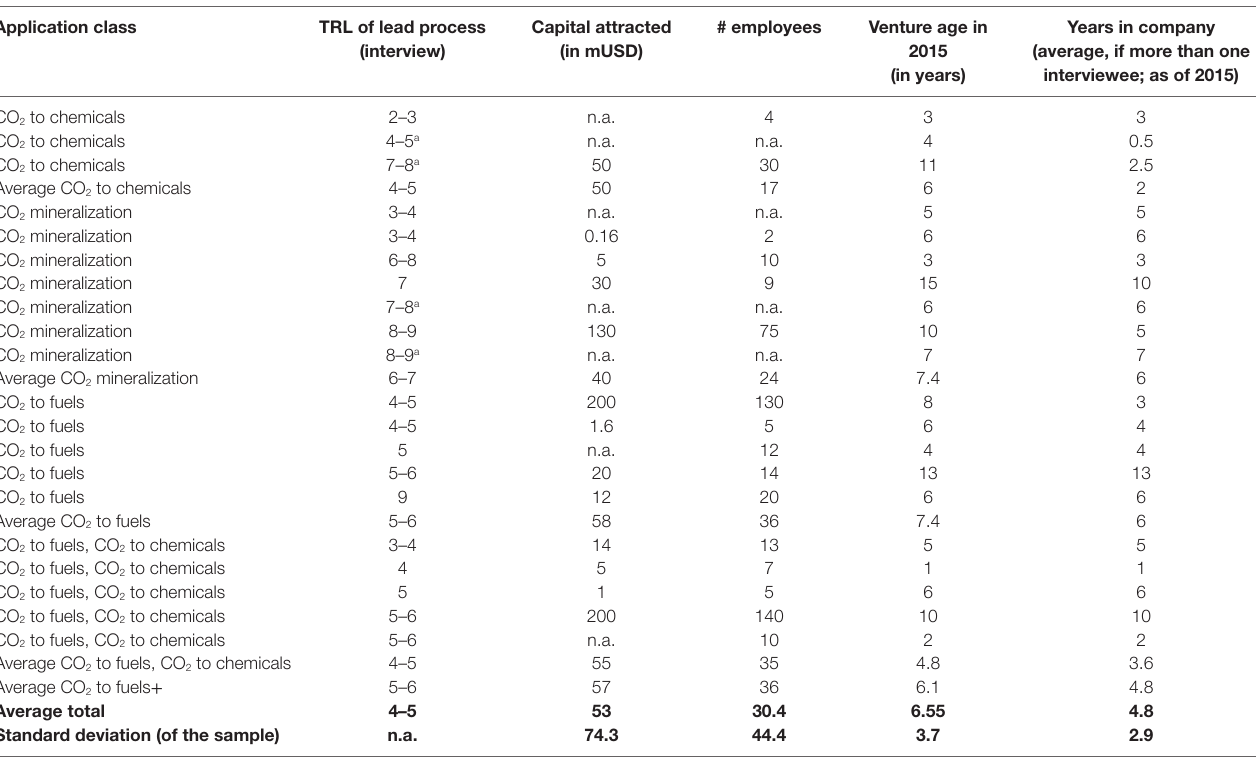
TaBle 5 | Overview of sample